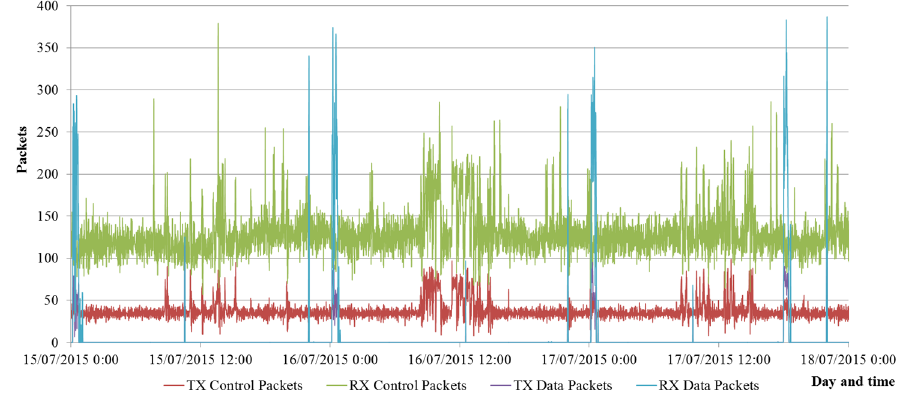
Figure 10. Control and data packets (transmitted –TX ‐ and received –RX ‐ ) in a ITU ‐ T G.9904 subnetwork.